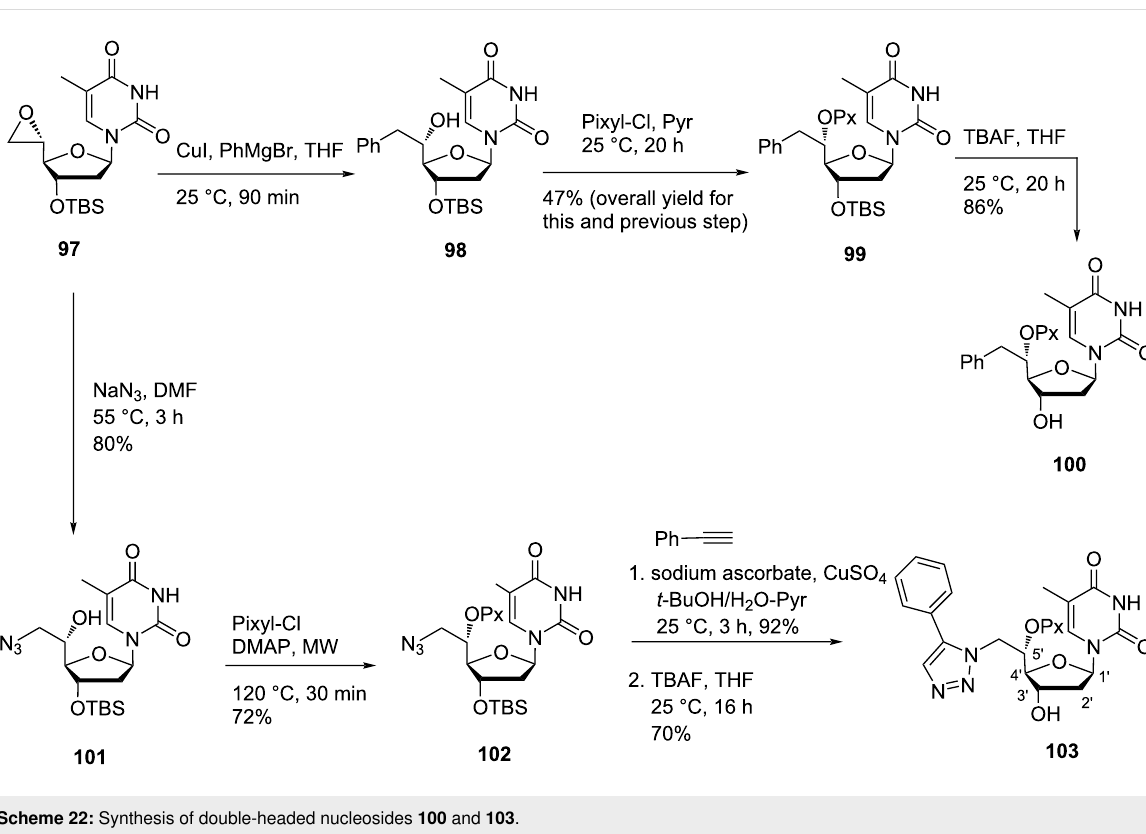
Scheme 22: Synthesis of double-headed nucleosides 100 and 103 .